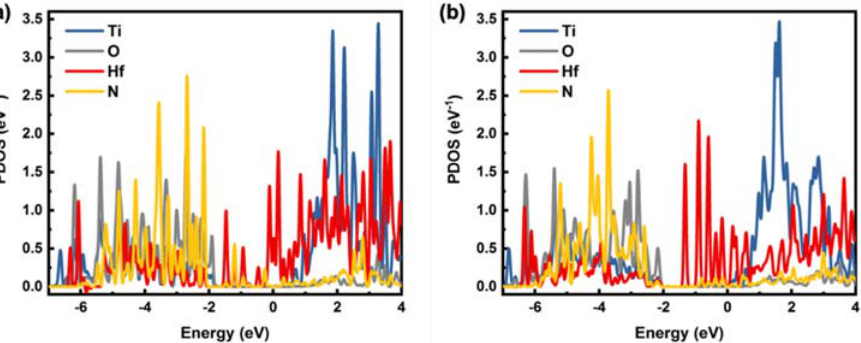
Figure 6. Projected density of states (PDOS) of selected atoms for HfN@TiO 2 heterostructures in far and close configurations. TiO 2 (101) and HfN (111) with Hf ‐ edge planes are located at far ( a ) and close ( b ) configurations.